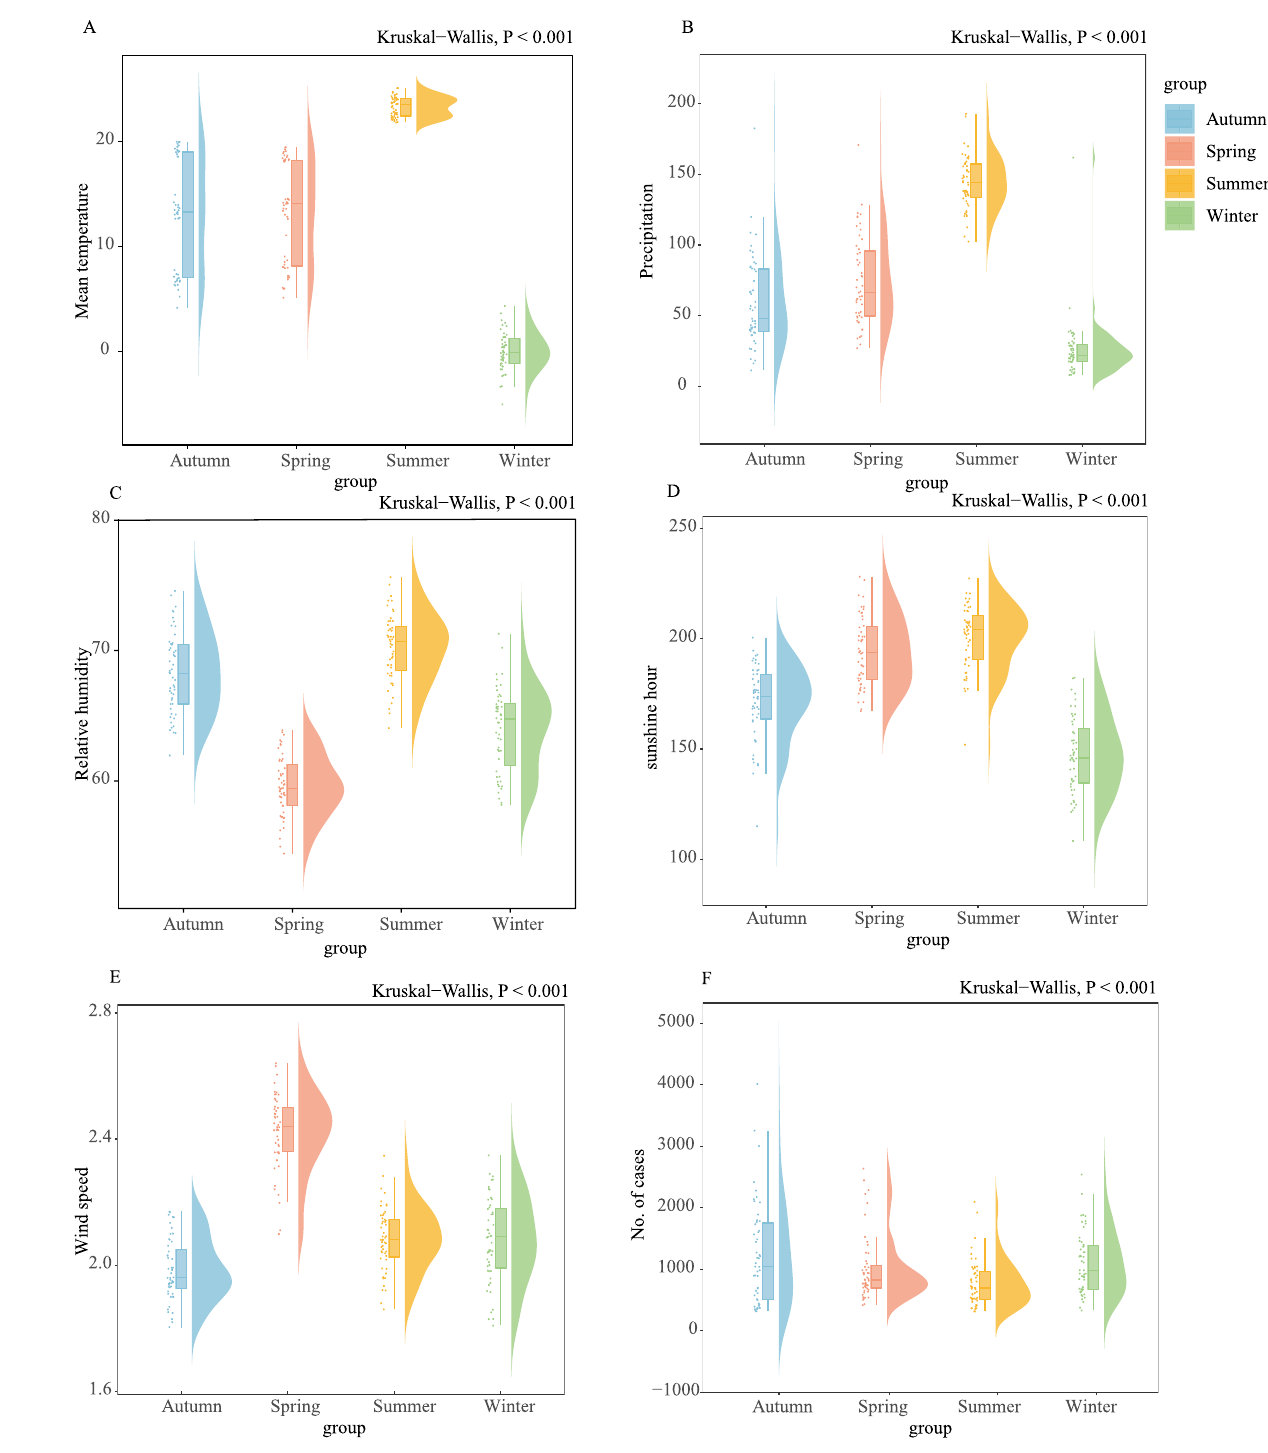
Figure 2. Boxplots of five meteorological variables and the number of HFRS cases in four seasons, 2004–2018 (n = 15*93 in each season). ( A – F ) Seasonal patterns of weather conditions. The Kruskal–Wallis test was used to compare the nonnormally distributed characteristics of five meteorological factors and HFRS incidence among the four seasons. Null hypothesis: the median values across the four seasons are equal. Alternative hypothesis: At least one of the median values of the four seasons is different from the others. Spring (March–May), summer (June–August), autumn (September–November) and winter